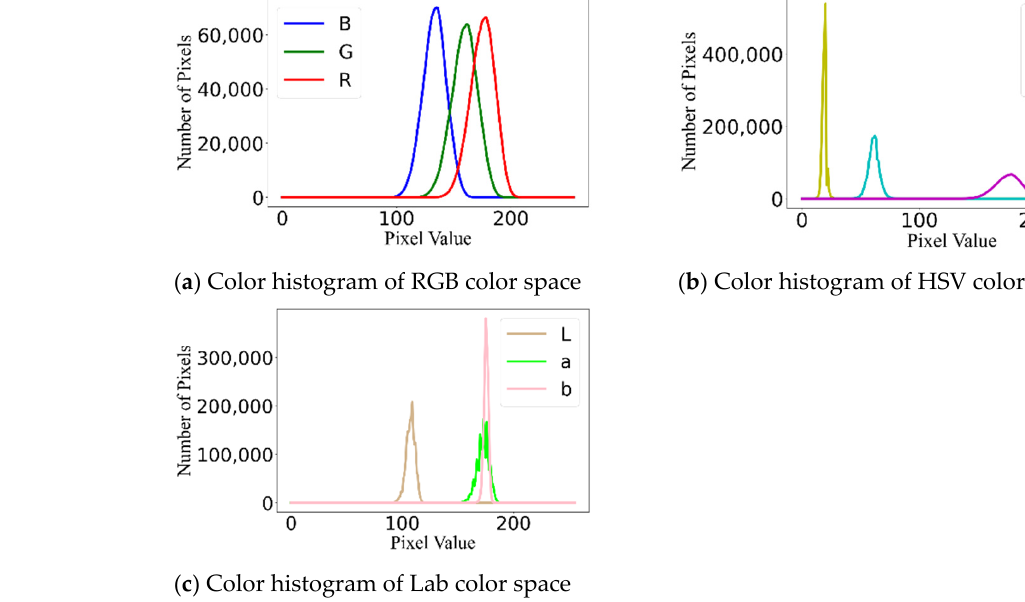
Figure 3. Color histogram of beech panel in RGB, HSV, and Lab color space.